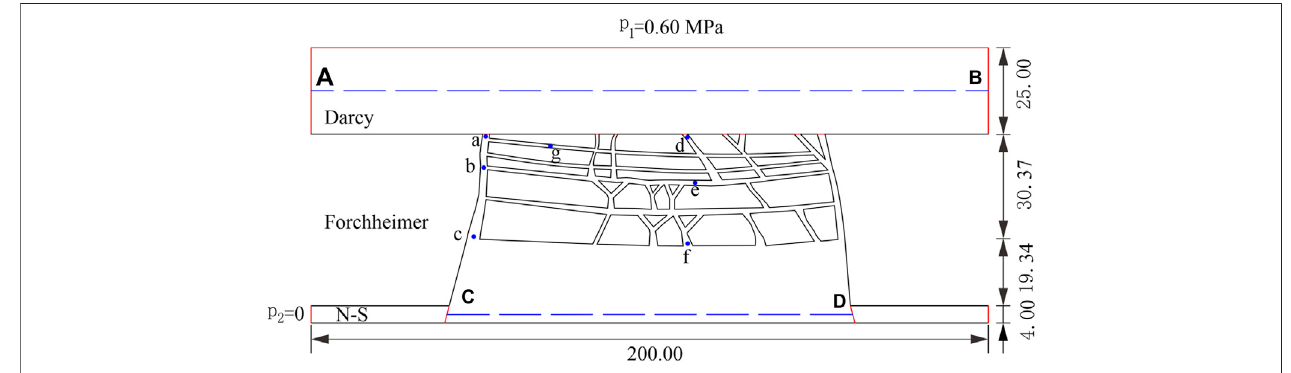
FIGURE 10 | Numerical model of water inrush in No. 18401 Panel.